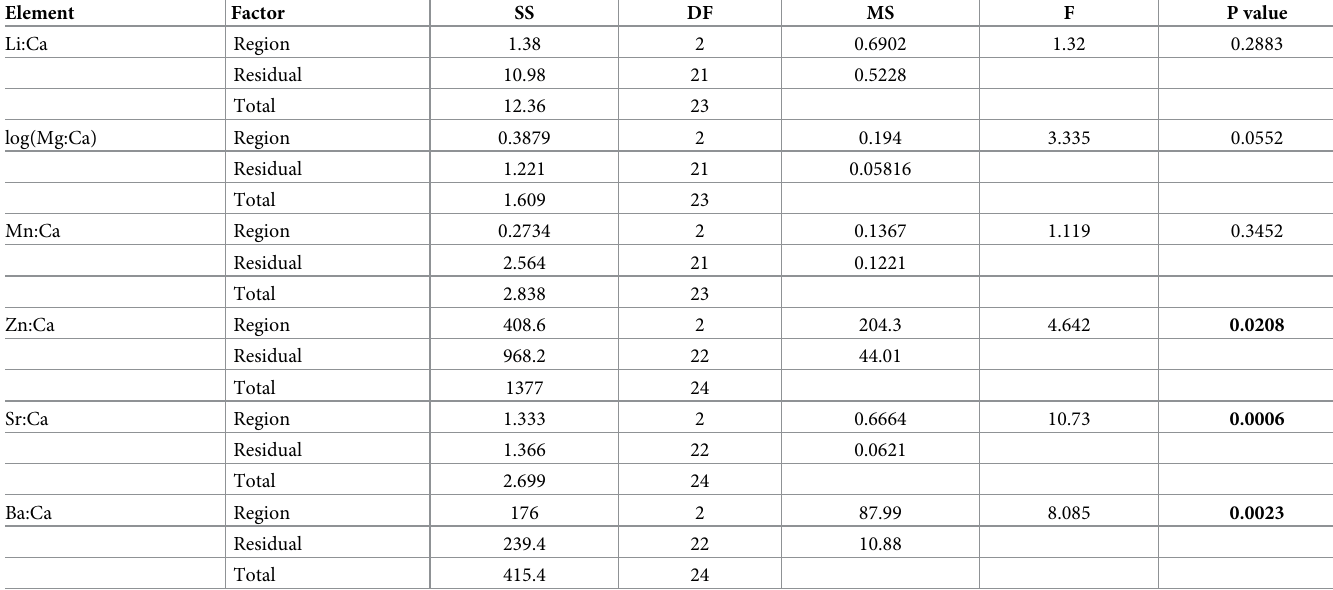
Table 2. One-way ANOVA results based on mean otolith edge (outer 100 μ m) element:Ca values for Pacific bluefin tuna for exploring regional differences in otolith chemistry among the eastern Pacific (EPO), western Pacific (WPO) and south Pacific (SPO). Only Mg:Ca was log transformed to meet normality assumption.